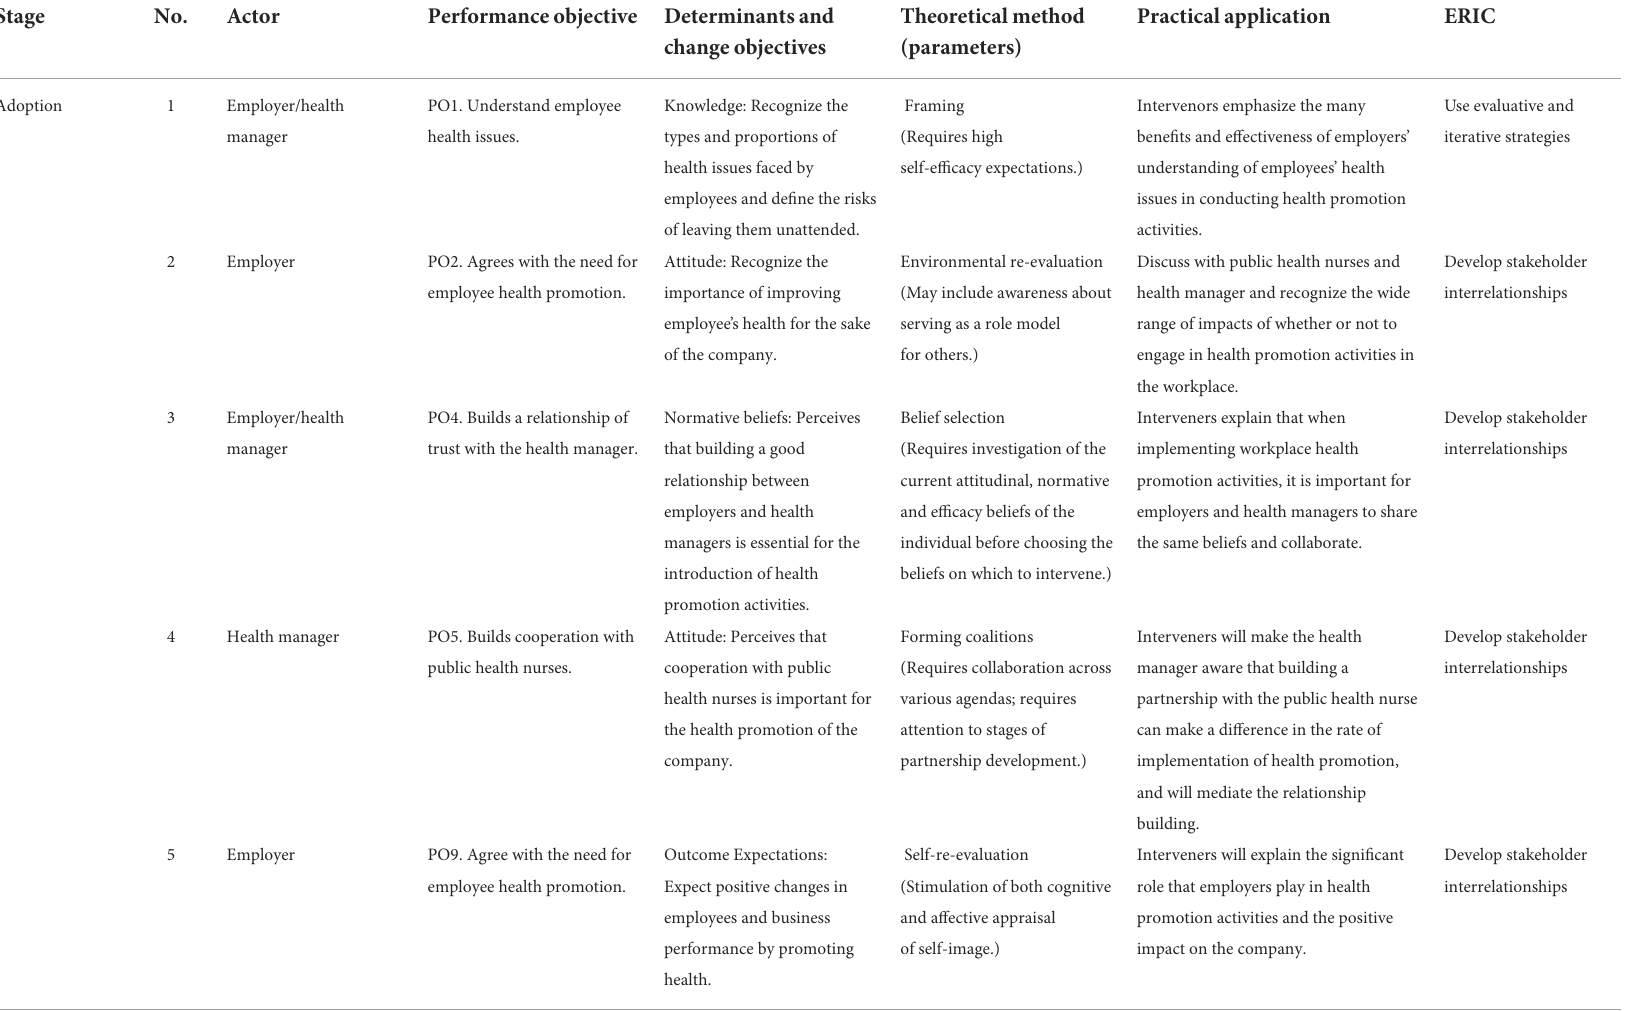
TABLE 4 Implementation strategies in health promotion activities within small- to medium-enterprises.